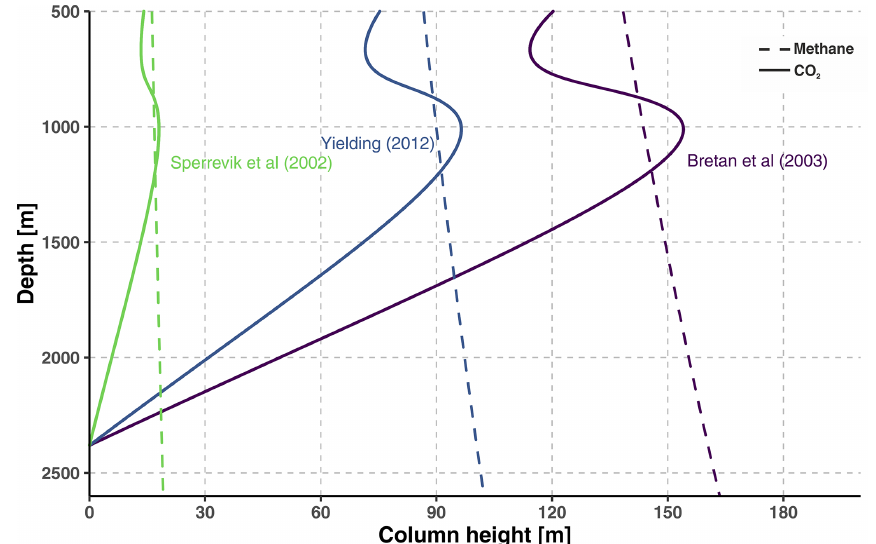
Figure 8. Supported column heights of a fault with a phyllosilicate-rich fault rock (SGR = 40) depending on the depth of the fault and the trapped fluid. For CO 2 the column height decreases with depth (after an optimum at ∼ 1000m of depth), while methane column heights increase with depth. Based on depth–wettability relationships for CO 2 by Iglauer